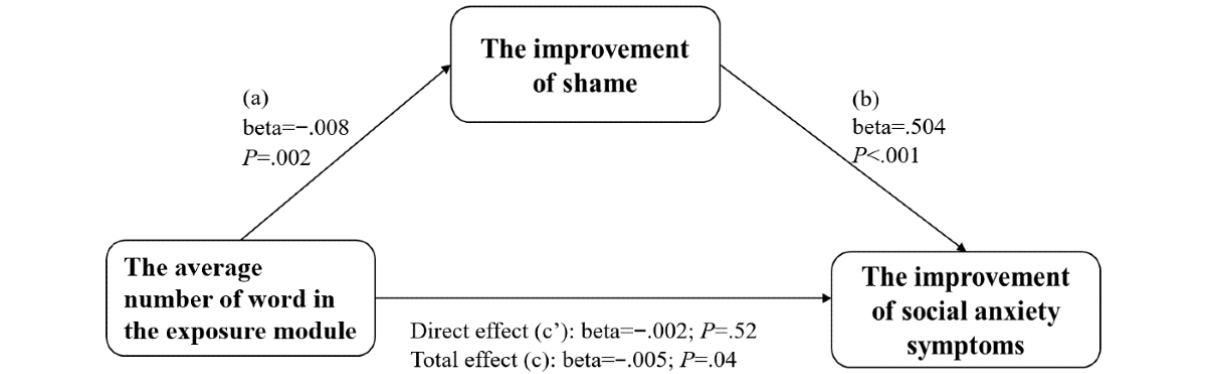
Figure 3. The mediation effect of shame improvement on exposure to Social Phobia